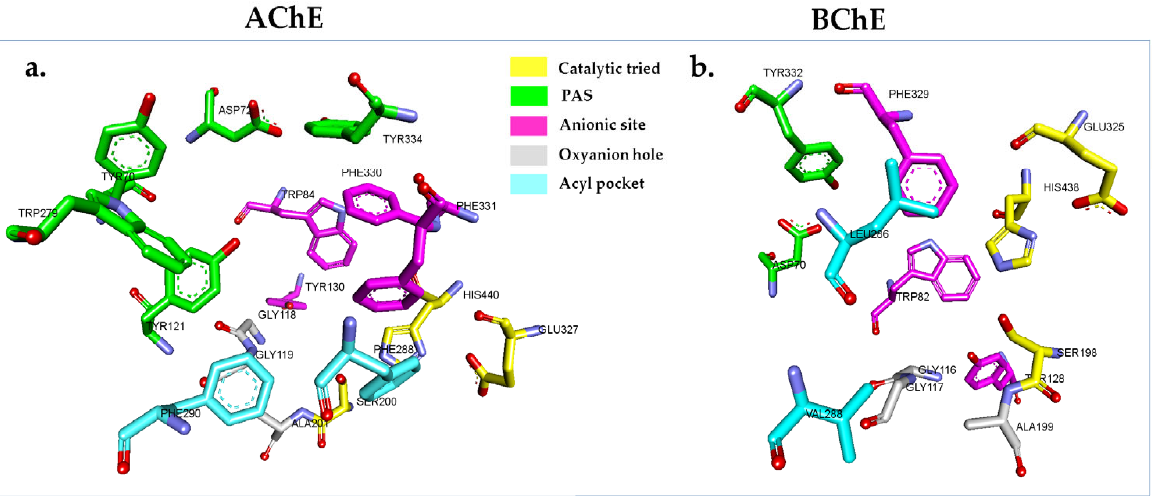
Figure 3. Binding site residues using BIOVIA Discovery Studio Visualizer (San Diego, CA, USA, 2019). ( a ). Torpedo californica acetylcholinesterase ( Tc AChE) (PDB:1W6R). ( b ). Homo sapiens butyryl- cholinesterase ( Hs BChE) (PDB: 4BDS).